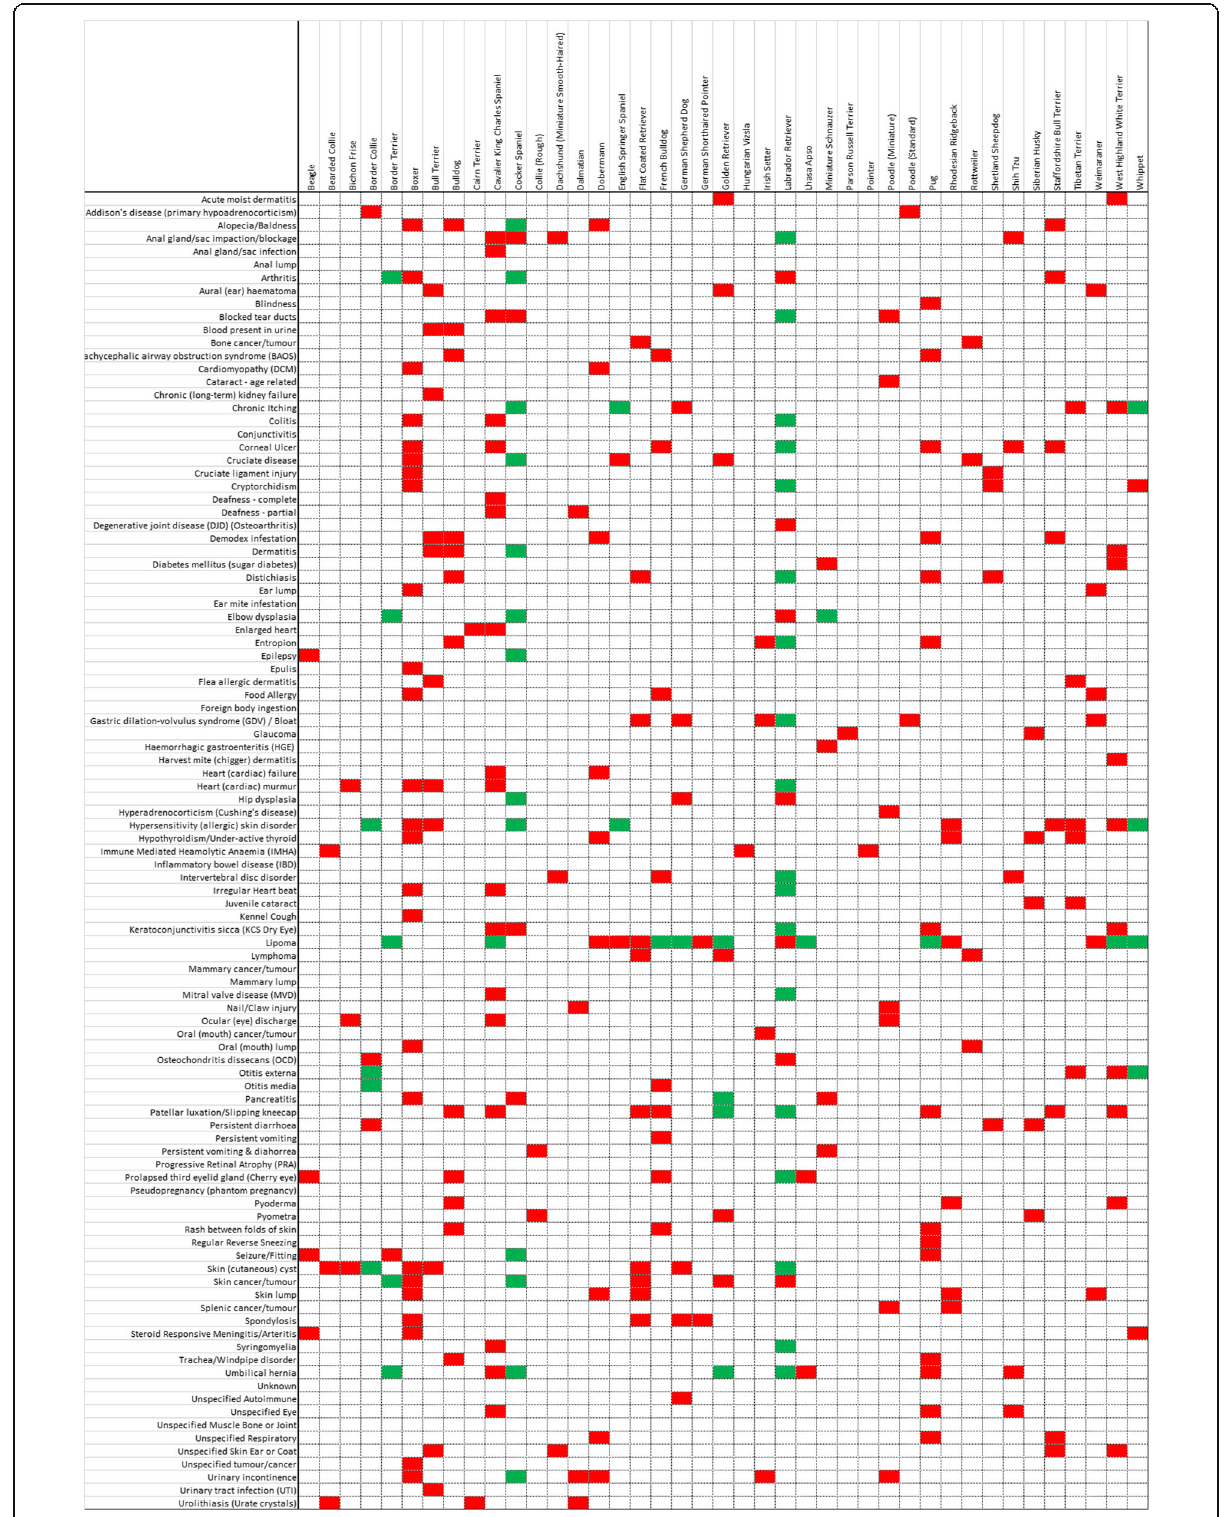
Fig. 2 Matrix showing significantly higher ( red ) or lower ( green ) within breed prevalence than the across breeds mean prevalence of the n = 101 most commonly reported conditions ( ≥ 50 reports, rows) across the n = 41 breeds with the most responses on unique live dogs ( ≥ 200 dogs, columns). A full size version of this figure, as well as a black and white version is available in Additional files 5 and